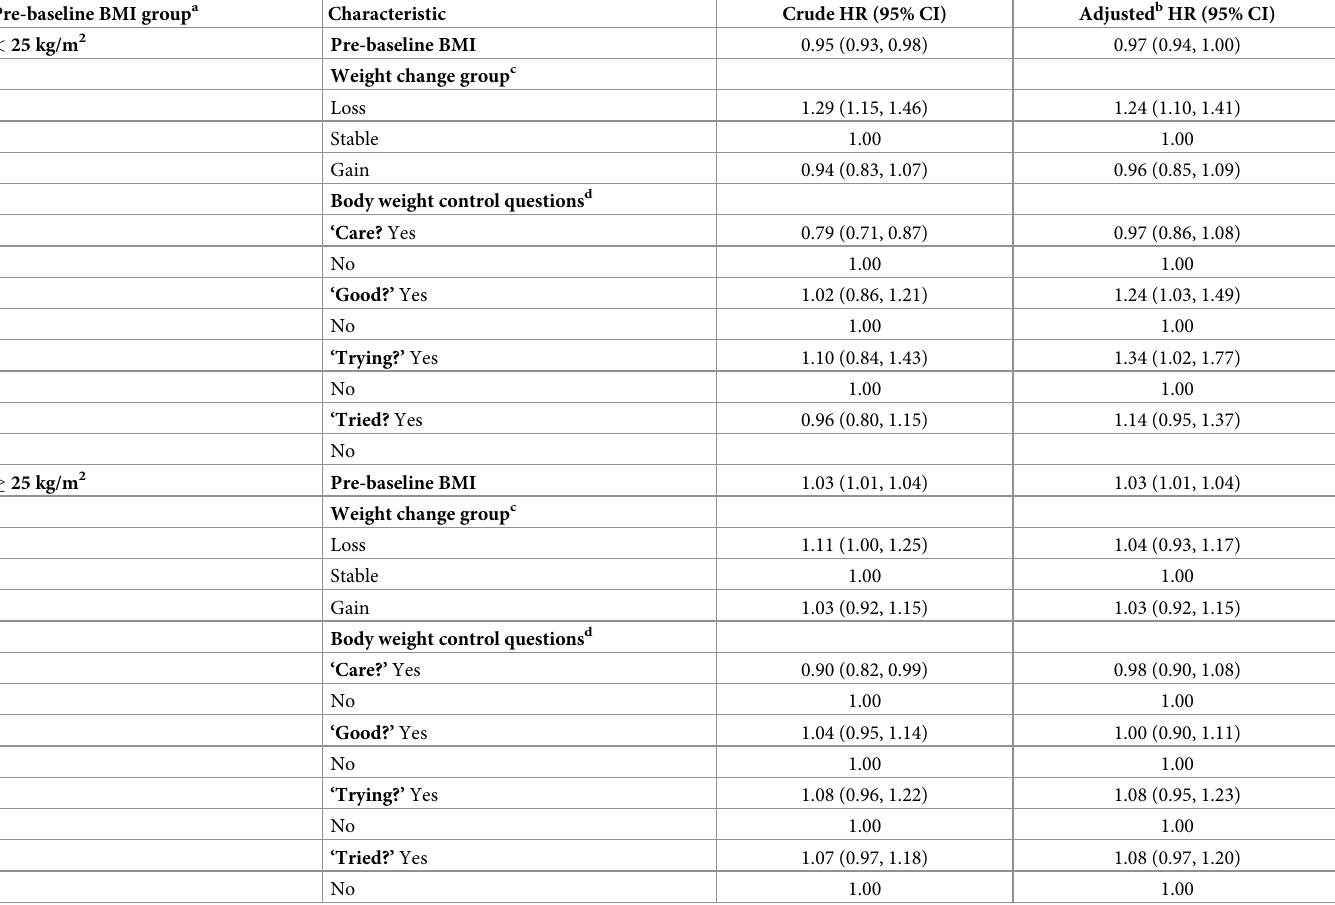
Table 1. All-cause mortality according to pre-baseline BMI, body weight changes and body weight control questions. Pre-baseline BMI group